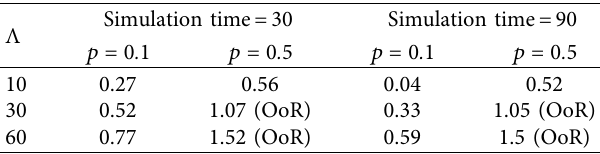
Table 8: Results for scenario 4 aimed to get minimum μ required to I ( t ) ⟶ 0.